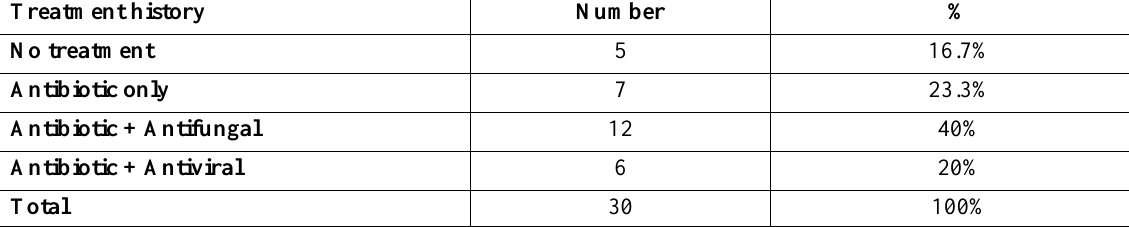
Table 4. Distribution of history of previous treatment among the studied group. Treatment history